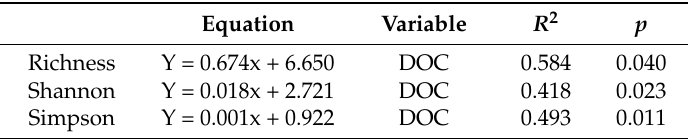
Summary of linear regression models for the effects of soil variables on microbial community